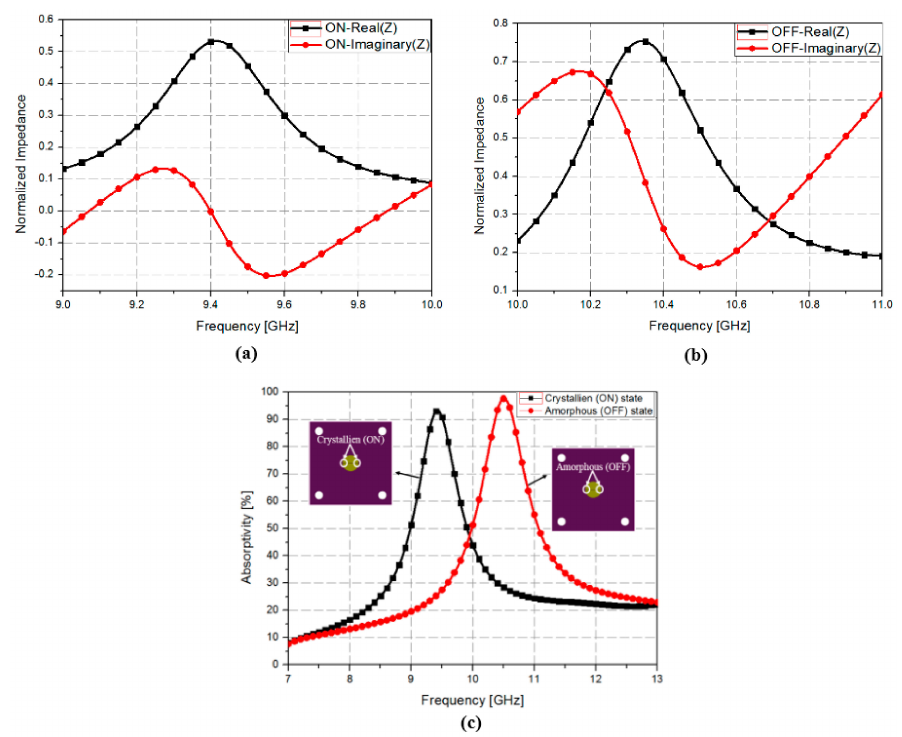
Figure 4. Normalized real and imaginary parts of the impedance of the proposed absorber in the ( a ) crystalline (ON) and ( b ) Amorphous (OFF) states. ( c ) Simulated absorptivity versus frequency for GeTe in different